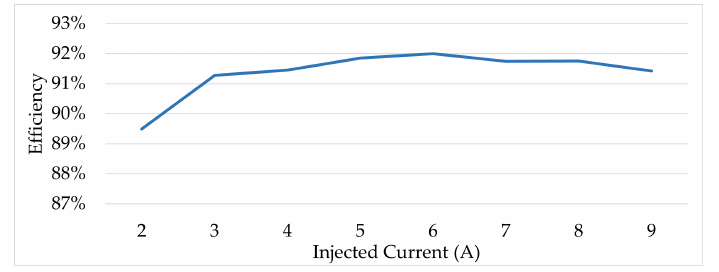
Figure 26. Efficiency versus injected current for operation modes 6 and 7.